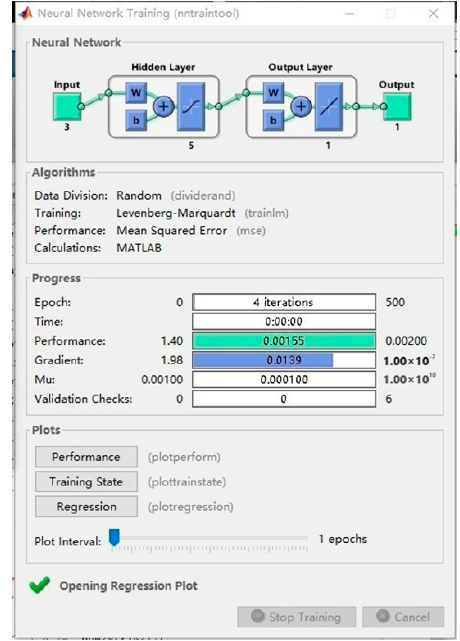
Figure 19. BP Neural network control process.